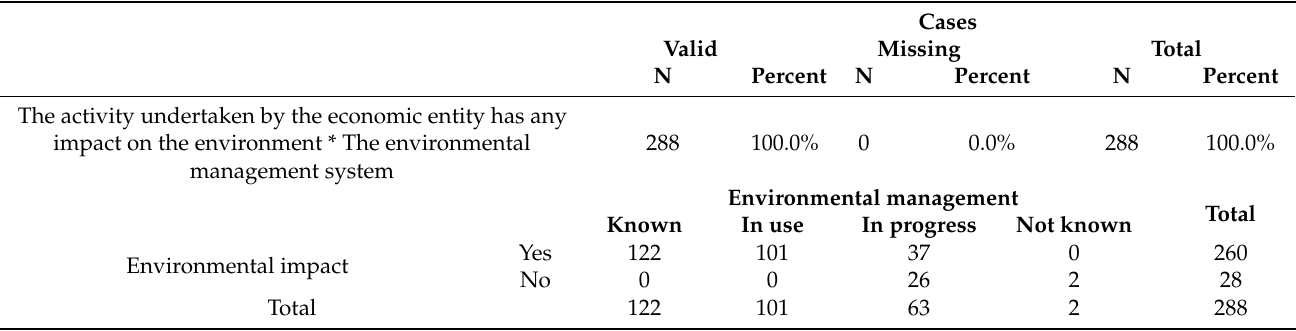
Table 10. Analysis of the symmetry of the variables environmental impact * environmental manage- ment system.